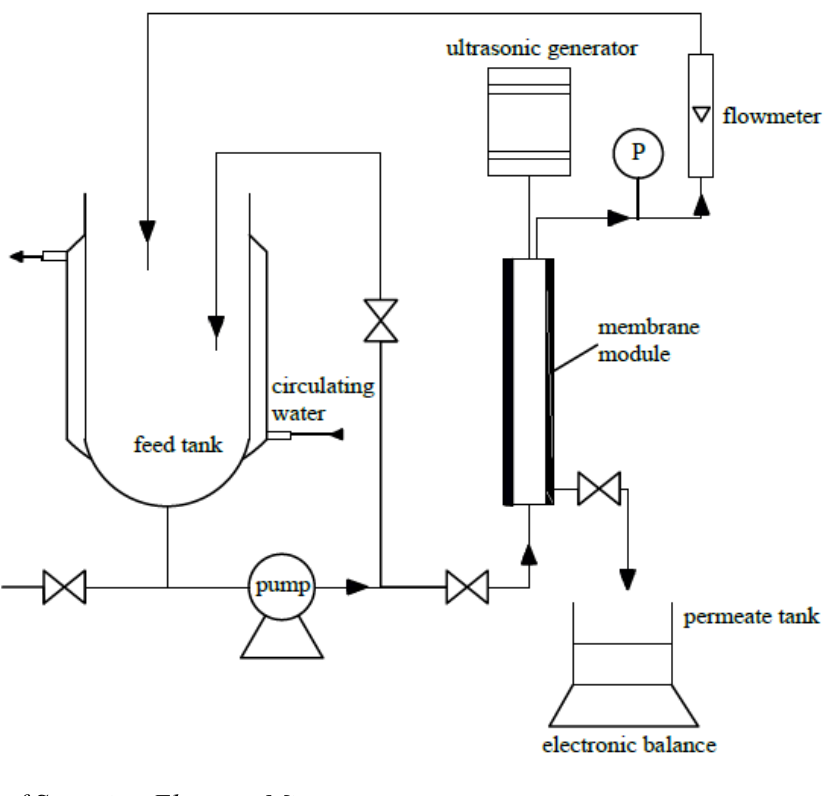
Figure 10. Schematic diagram of crossflow microfiltration